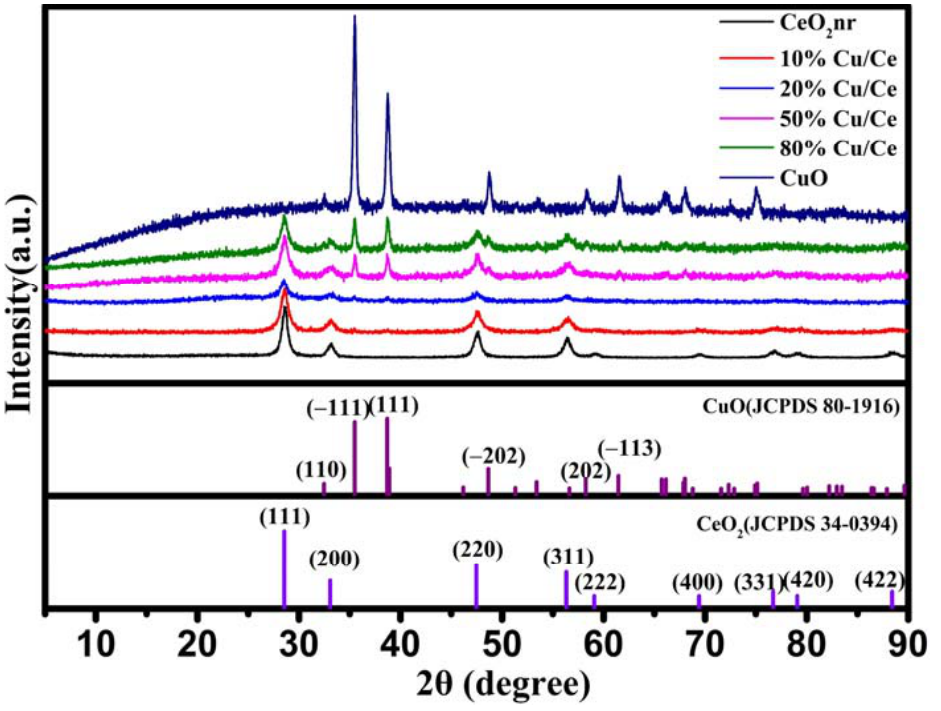
Figure 2. XRD patterns of the as-prepared CuO/CeO 2 catalysts. Table 1. Physical properties of the as-prepared CuO/CeO 2 catalysts.